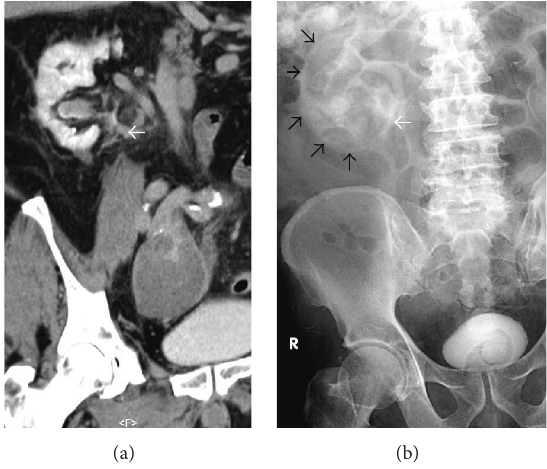
Figure 2: (a) The multiplanar reformation of the CT in excretory phase of the abdomen shows a collection of excreted contrast mixed with urine (arrow) in the soft tissue at renal hilar and parahilar regions. (b) The plain KUB radiograph after CT scan shows the correlated area of contrast leakage (white arrow) seen from CT scan and also additional perinephric contrast collection (black arrows).